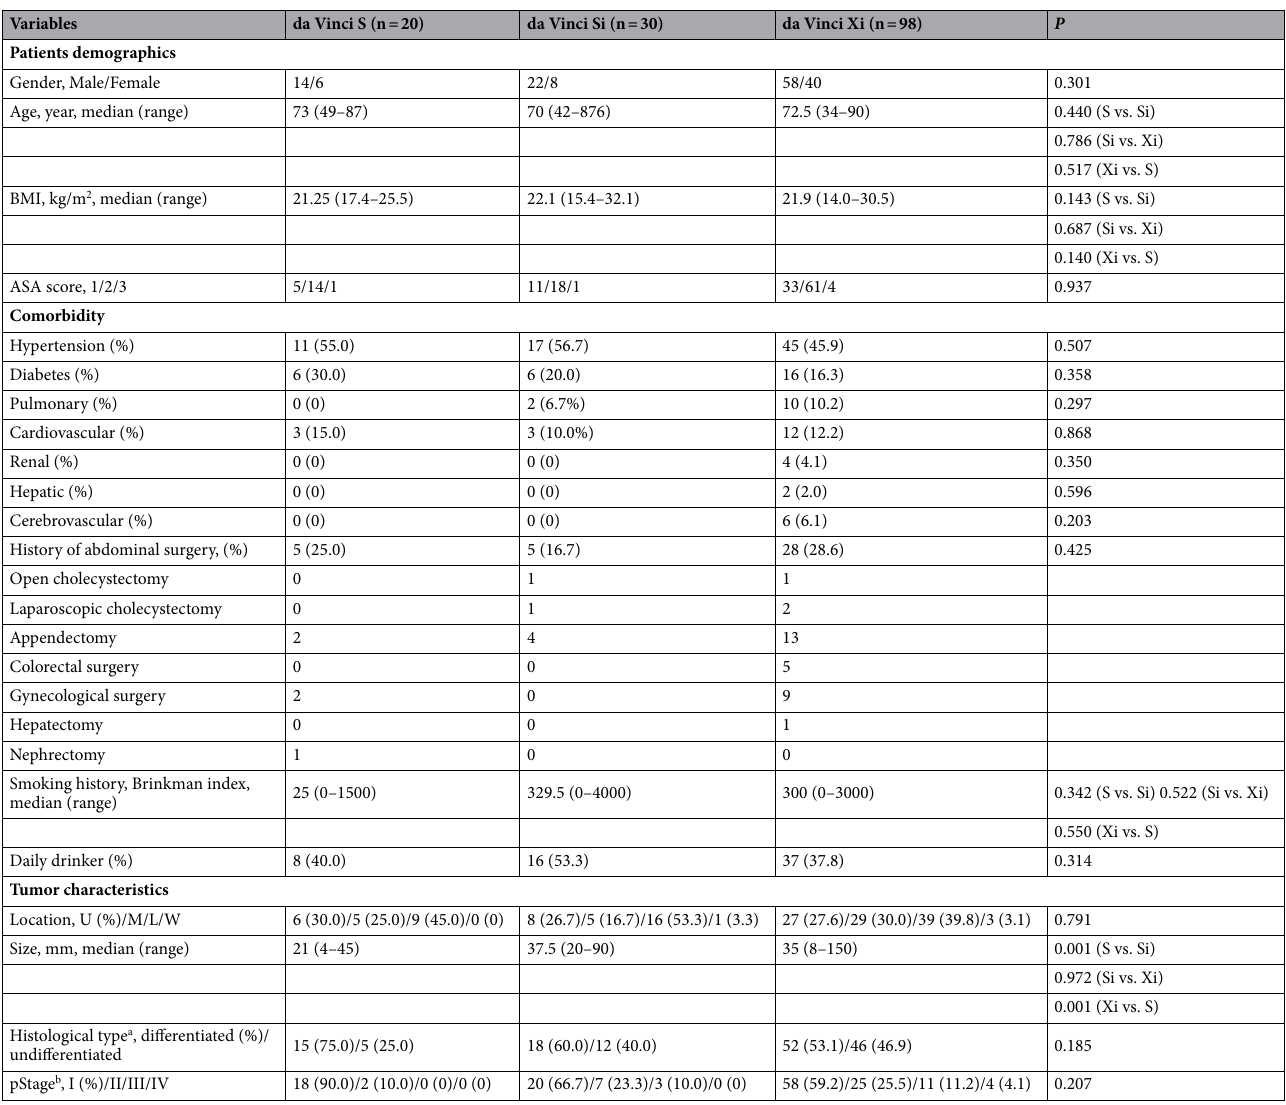
Table 1. Patient demographics and tumor characteristics. BMI body mass index; ASA American Society of Anesthesiologists; U upper third of the stomach; M middle third of the stomach; L lower third of the stomach; W whole stomach. a Japanese Classification of Gastric Carcinoma. b UICC 8th